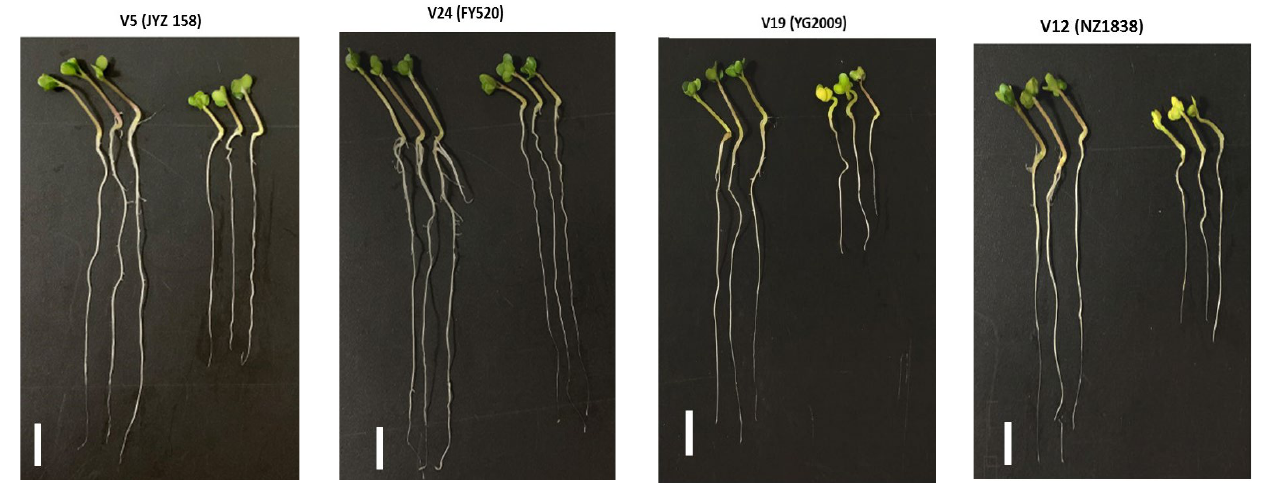
Figure 4. Effect of drought stress (15% PEG-6000) on the shoot and root growth of tolerant cultivars (JYZ 158 and FY 520) and sensitive cultivars (YG 2009, and NZ 1838). Scale bar: 1 cm.